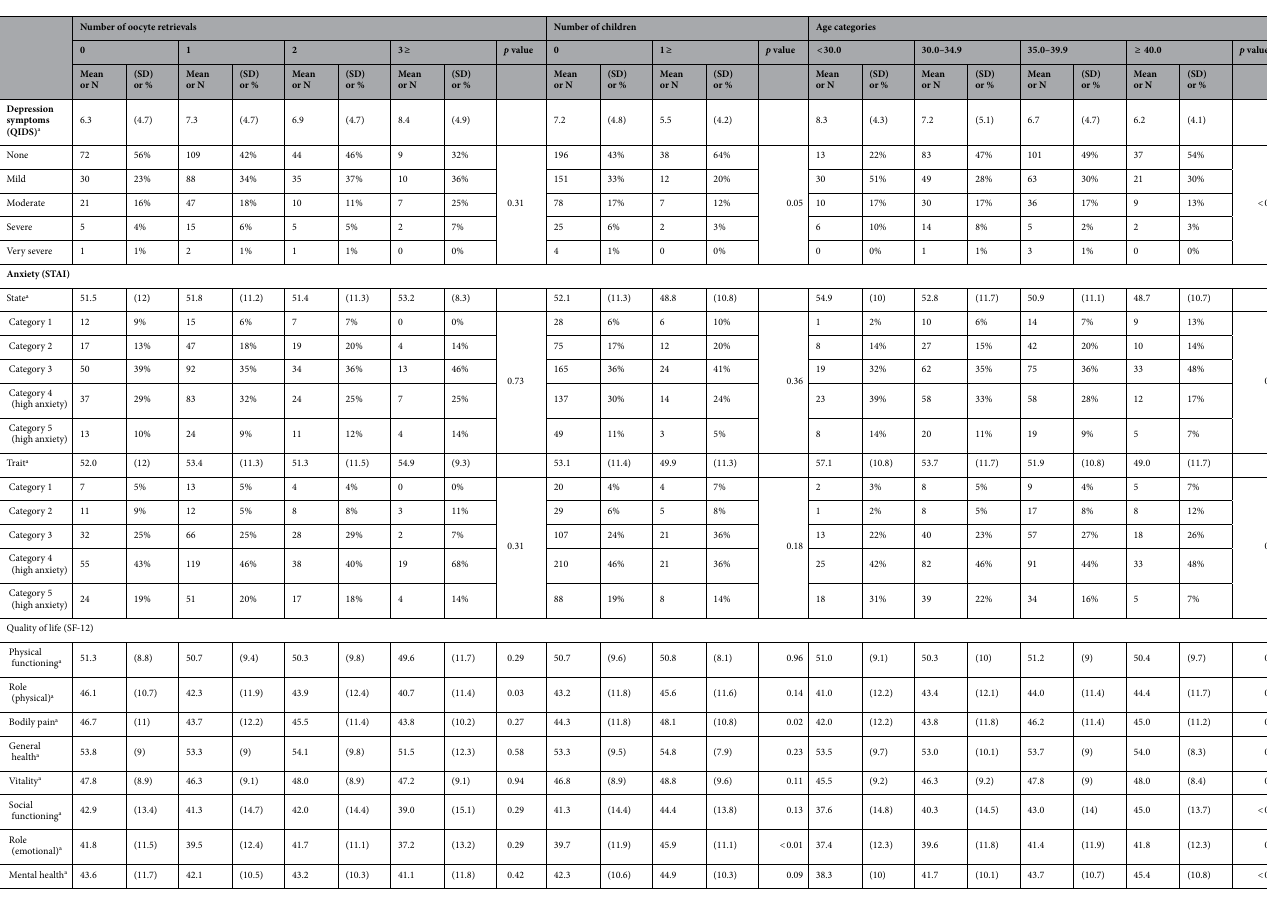
Table 3. Depressive symptoms, anxiety, and quality of life among participants, stratified by number of oocyte retrievals, number of children, and age categories ( n = 513). To calculate p values, we used Chi-square testing for QIDS and STAI (state and trait) and simple linear regression for subscales of SF-12 treating categories as ordinal. a Mean and standard